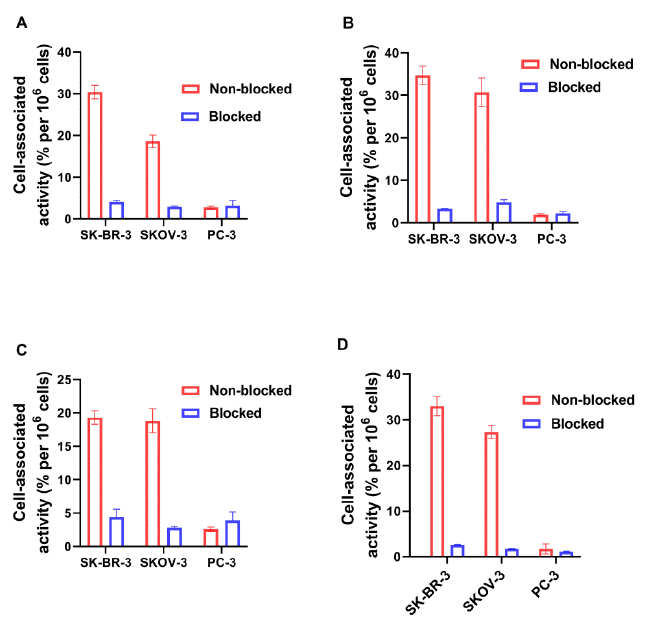
Figure 4. Binding specificity of radiolabeled G3 variants to HER2-expressing SK-BR-3, SKOV-3, and PC-3 cells in vitro. ( A ) [ 99m Tc]Tc-G3-G 3 C, ( B ) [ 99m Tc]Tc-G3-(G 3 S) 3 C, ( C ) [ 99m Tc]Tc-G3-E 3 C, and ( D ) [ 99m Tc]Tc-(HE) 3 -G3. For blocking, a 100-fold molar excess of non-labeled G3 was added to the blocked groups. The final concentration of radiolabeled compounds was 1 nM. The data are presented as the mean from three samples ±